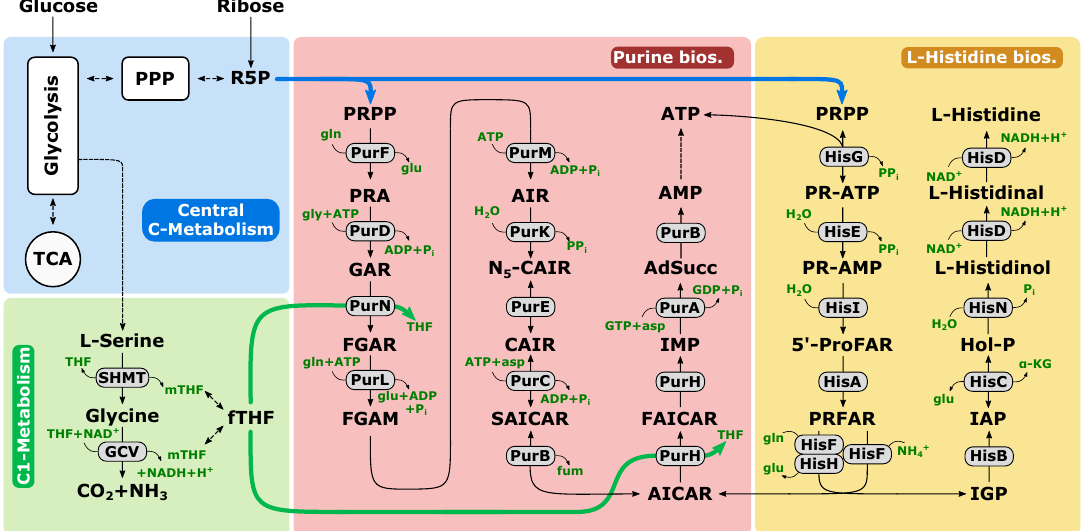
Hol-P, l -histidinol phosphate; IAP, imidazole-acetole phosphate; IGP, imidazole-glycerol phosphate; IMP, inosine monophosphate; mTHF, 5,10- methylenetetrahydrofolate; N 5 -CAIR, 5 (cid:48) -phosphoribosyl-4-carboxy-5-aminoimidazole; NAD +/ NADH, oxidized / reduced nicotine amide dinucleotide;